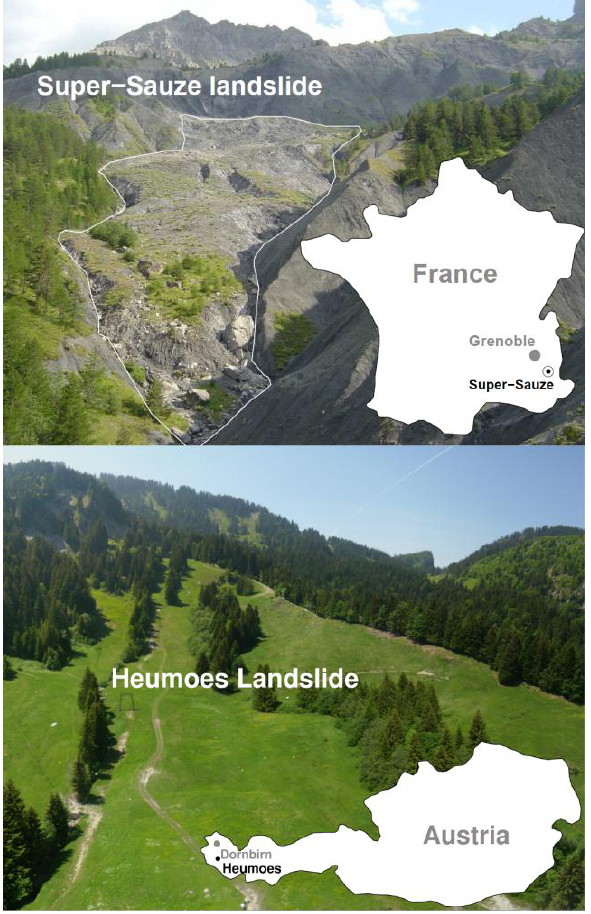
Figure 1. Top: view onto the Super-Sauze landslide, bottom: view onto the Heumoes